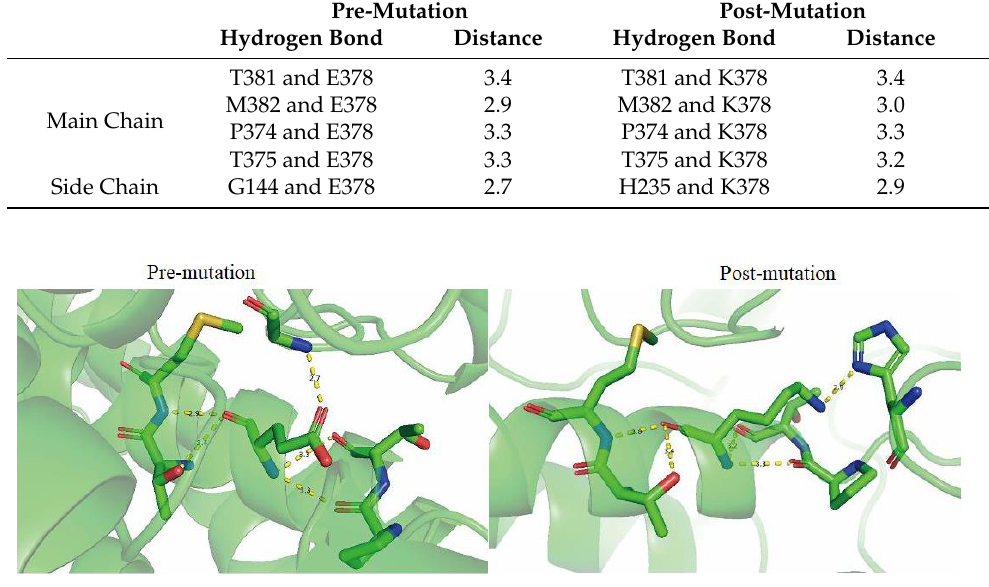
Figure 8. The predicted effects on the three-dimensional structure visualized by PyMOL.